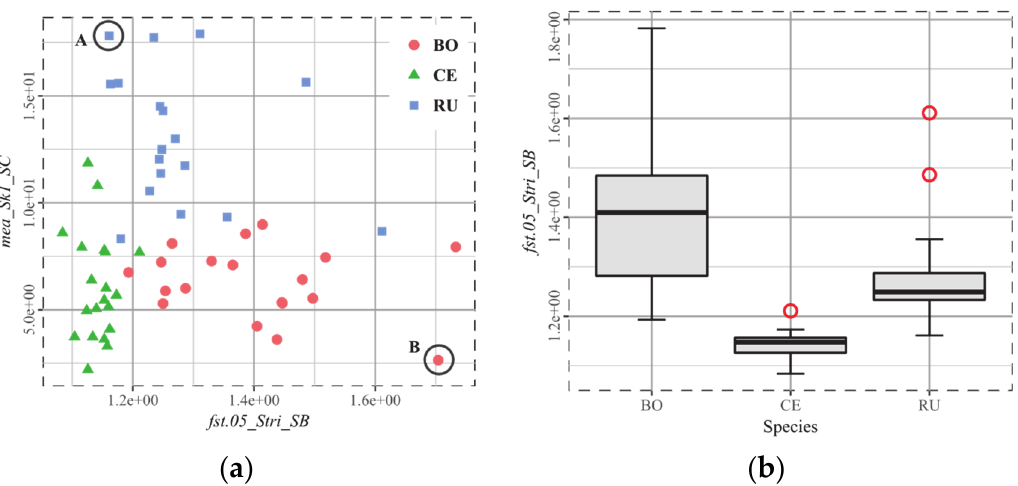
Figure 4. European Ruminants, most discriminating parameters. RU ‐ BO mea_Sk1_SC p ‐ value: 2.96 × 10 − 9 , RU ‐ CE p ‐ value=1.29 × 10 − 10 . ( a ) The anisotropy parameter Stri makes a clear distinction between Cervus elaphus (CE) and Bos taurus (BO). The surfaces related to the points (A) and (B) are represented in the ESM; and, ( b ) Whereas BO spans a large range of Stri , CE Stri values remain around 1 (isotropic surface).